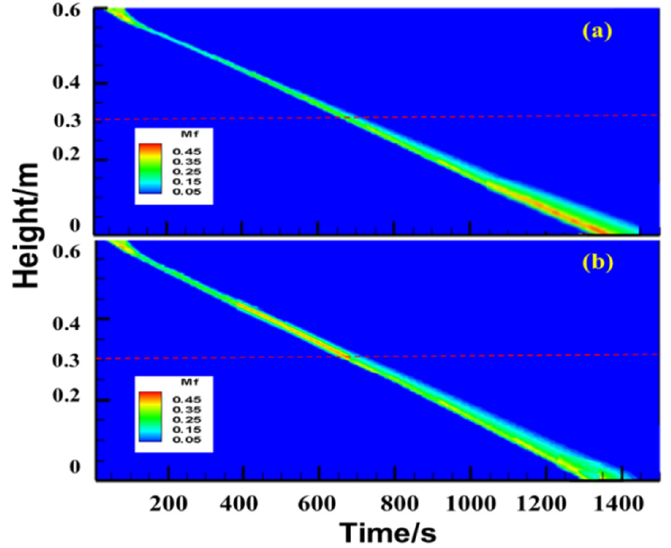
Figure 13. Melting fractions for the CS and FSDS technologies: ( a ) base case; ( b ) case I.